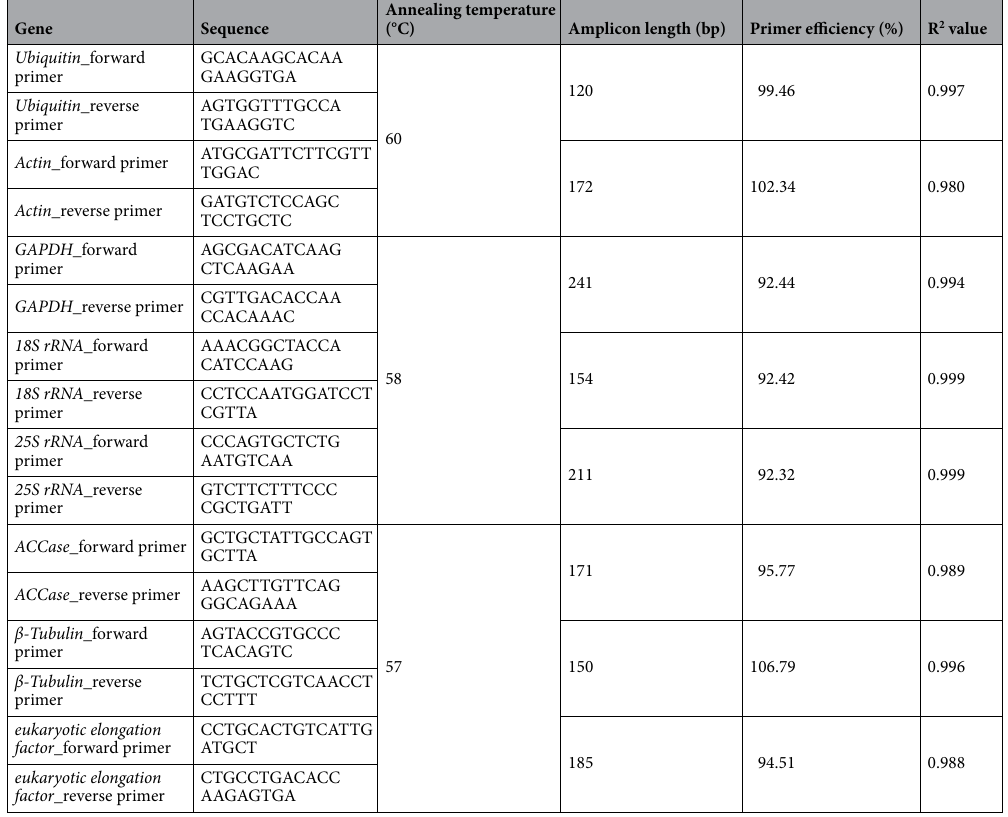
stable gene by ΔCt, BestKeeper and RefFinder, whereas NormFinder and geNorm analysis identified UBQ as the least stable gene for studies under drought stress on B. sterilis . Combined conditions. When all the conditions were taken together, 18S rRNA was identified as the most stable reference gene, irrespective of the method (Table 2, Fig. 2). NormFinder analysis results for combined conditions revealed that UBQ and ACCase could be considered the best reference gene, and the geNorm algorithm ranked 18S rRNA and ACCase , as the best reference gene (Table 2, Fig. 2). β-TUB was identified as the least stable gene by comparative ΔCt, BestKeeper and RefFinder, whereas NormFinder and geNorm analysis identified GAPDH as the least stable gene. Pairwise variation analysis. The pairwise variation (Vn/Vn + 1) was calculated based on the geNorm algorithm. The optimal number of the reference genes required for the normalisation were determined from the pairwise variation results, based on the average expression stability (M) values (cutoff: M < 1.5). The optimal number of the reference genes required for the normalisation for experiments related to the developmental stages and plant organs are 1 and 2, respectively. However, to avoid any biases in the normalization, we recom- mend using 2 reference genes for developmental stages. Hence, we recommend using 18S rRNA and ACCase , as housekeeping genes for developmental stages and plant organ-related studies in B. sterilis . Under drought stress, 4 candidate genes ( 18S rRNA , β-TUB , 25S rRNA and ACCase ) were considered suitable for normalisation. When all the conditions were considered together, the pairwise variation result suggested that 2 reference genes will be required for the normalisation (Fig. 3). Therefore, 18S rRNA and ACCase were identified as the most suitable gene when all the conditions were considered together. Relative expression of the acetolactate synthase ( ALS ) gene under herbicide stress. Based on the analysis of the commonly used software for reference gene analysis, 18S rRNA and a combination of 18S rRNA and ACCase were identified as the most suitable candidate genes for gene expression studies in Bromus sterilis, whereas β-TUB as the most unstable gene. To validate the reliability of the candidate genes, relative expression of the acetolactate synthase under herbicide stress was evaluated using the best and the least stable candidate genes. When normalised with 18S rRNA and a combination of 18S rRNA and ACCase, B. sterilis bio- type showed twofold ALS gene overexpression after herbicide treatment compared to the control, whereas with β-TUB , the result is almost eight times (Fig. 4).